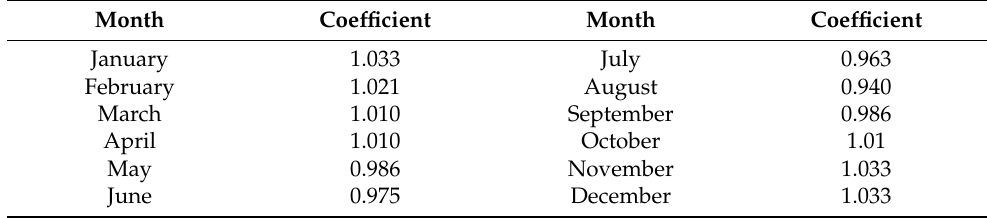
Table 5. Monthly coefficients representing the operation of restaurants in